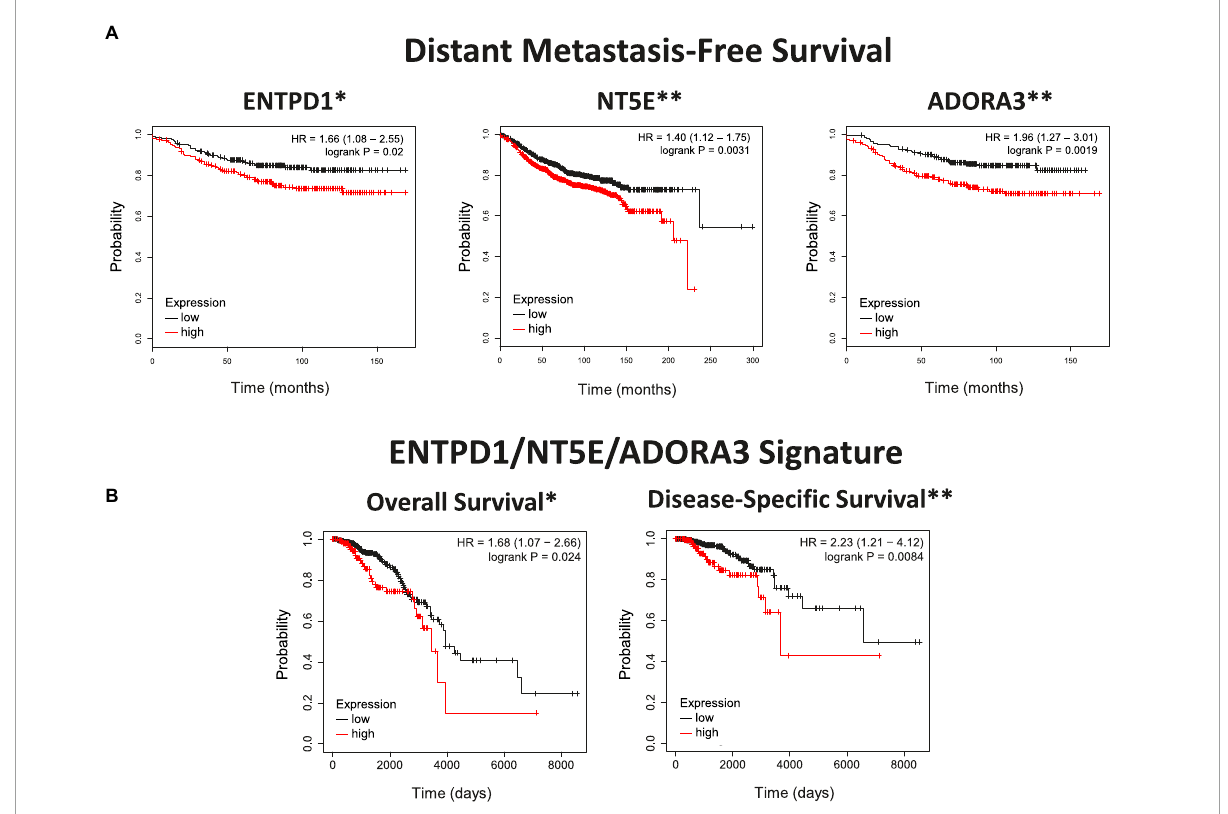
FIGURE1 ENTPD1, NT5E, and ADORA3 expression in primary ER + breast cancer correlates with poor outcomes. (A) Kaplan Meier plots of distant metastasis-free survival in ER + breast cancer. The high-expression groups for ENTPD1 (HR = 1.66), NT5E (HR = 1.4), and ADORA3 (HR = 1.96) all have a significantly greater chance of distant metastasis or death. Analysis was made using KMPlot (24) . (B) Kaplan Meier plots of overall and disease-specific survival of ER + breast cancer patients in the TCGA BRCA cohort based on ENTPD1/NT5E/ADORA3 signature expression (calculated by the average expression [log2(norm_count + 1)] of the three genes, and separated by median). In this separate cohort than (A) , the high-expression group had significantly lower overall and disease-specific survival (HR = 1.68 and 2.23, respectively). ∗ p < 0.05; ∗∗ p <